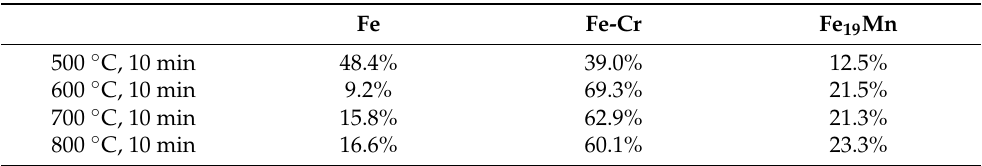
Table 4. Crystalline compositions of SS441 surfaces using the semiquantitative method and Bruker EVA XRD analysis software.